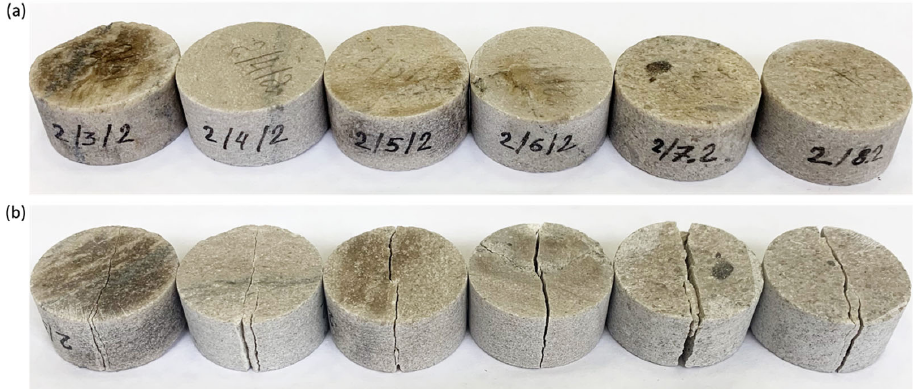
Figure 11. Photographs depicting water-wet limestone samples during indirect determination of the tensile strength through the Brazilian test: ( a ) samples before testing; ( b ) samples after testing.